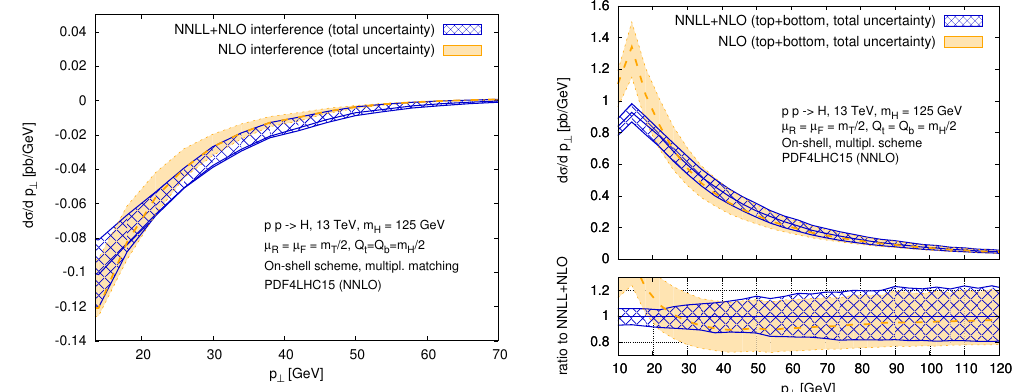
Figure 7 . The distributions for the top-bottom interference contribution (left) and the full NNLL matched result (right), using the multiplicative scheme with resummation scale Q b = Q t = m h = 2 as central values. See text for